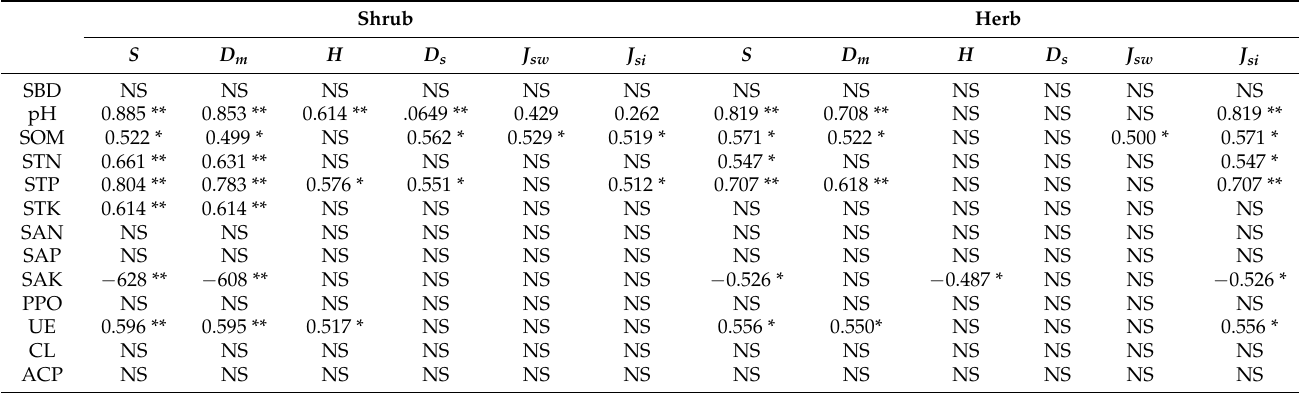
Table 5. Correlation analysis between undergrowth vegetation species diversity and soil properties. Soil property dates were the depths of 0–20 cm. PPO = polyphenol oxidase, UE = urease, CL = cellulase, ACP = acid phosphatase, other abbreviations are the same as Figure 1. Asterisks represent the p -value: * = p < 0.05, ** = p < 0.01. NS = non-significant. Shrub